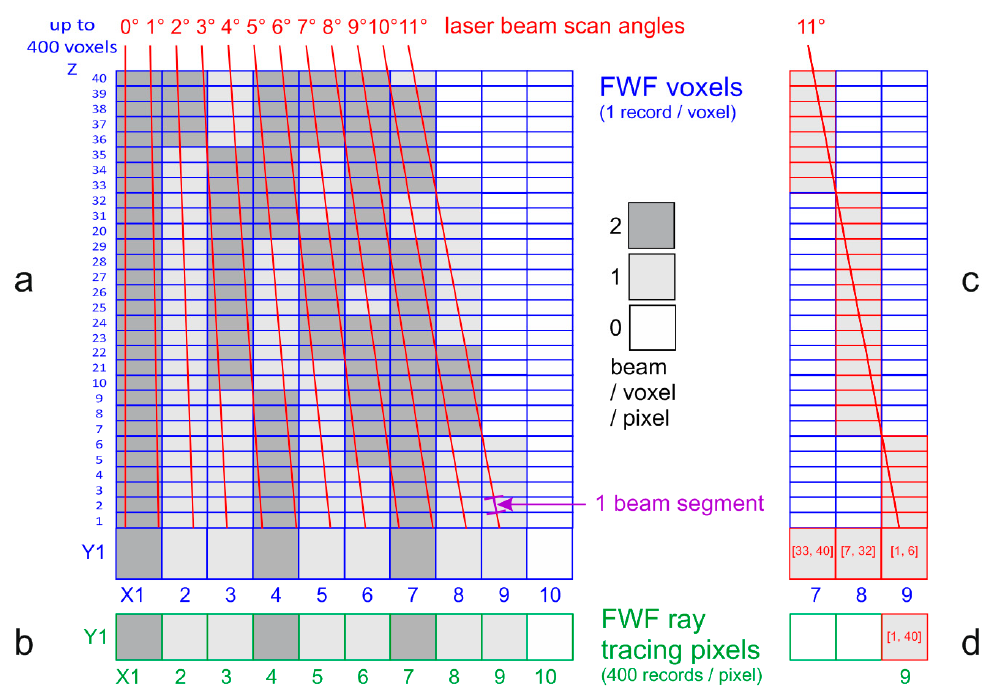
Figure 2. Full waveform (FWF) averaging along a line Y: ( a ) diagram of the voxelization example of 10 laser beams intersecting the Y line section of an XYZ grid of voxels 0, 1, or 2 times; ( b ) strip X of one line Y used to localize ray tracing anchorage on pixels where FWF records are cumulated in a stack of N channels as in hyperspectral images, which therefore have the same light path; ( c ) the voxelization distributes the records of the 11° scan angle in three successive columns of voxels (7, 8, 9), whereas in ( d ), the ray tracing stacks all the records of the 11° scan angle in the N channels of one single pixel (9). The resolution is 0.5 m in the X and Y directions and 0.15 m in the Z and N directions, with Z being perpendicular to (X,Y), whereas N is a number of channels along each laser beam scan angle.